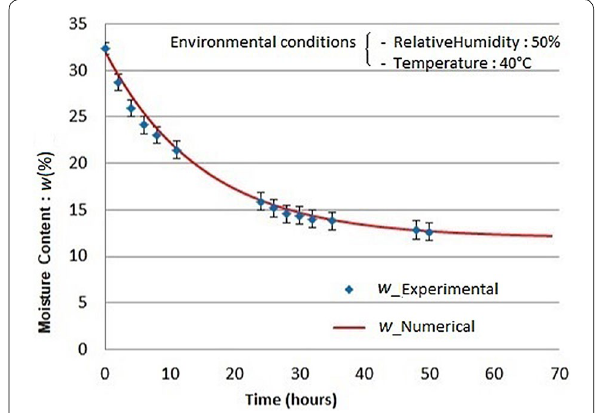
Fig. 8 Evolution of the moisture content during